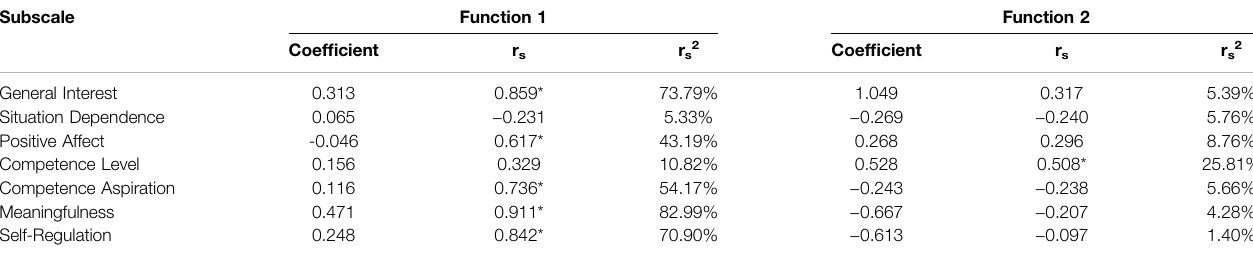
TABLE 3 | Standardized discriminant function and structure coef fi cients for the four phases of interest in X.